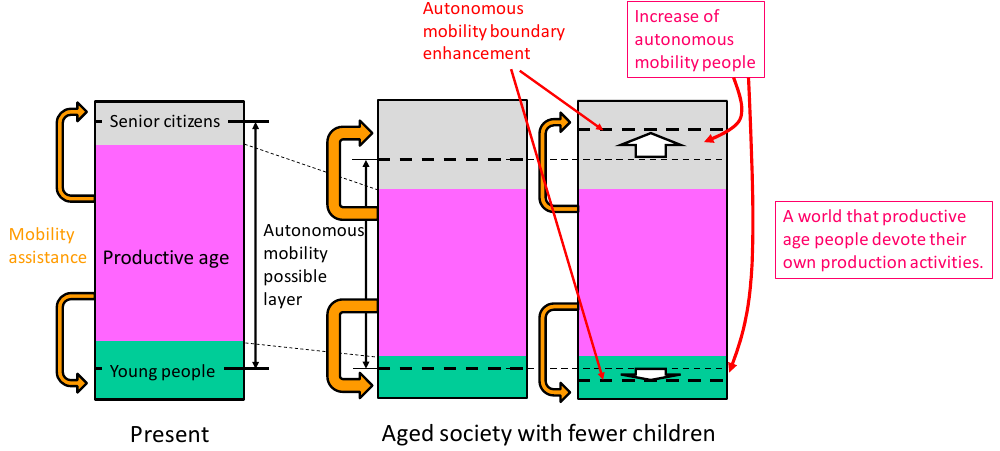
Figure 1. Ensuring the self-supportable mobility of elderly people and the vitality of society.